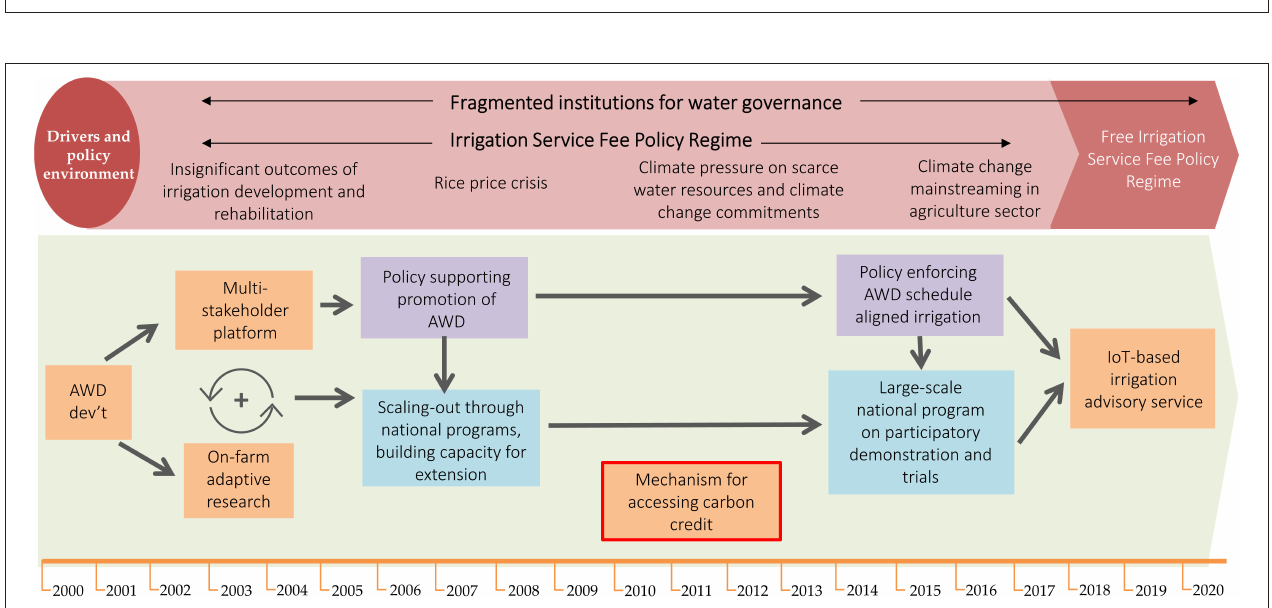
FIGURE 3 | Scaling trajectory of AWD in the Philippines, 2000–2020 (Sources: Authors)